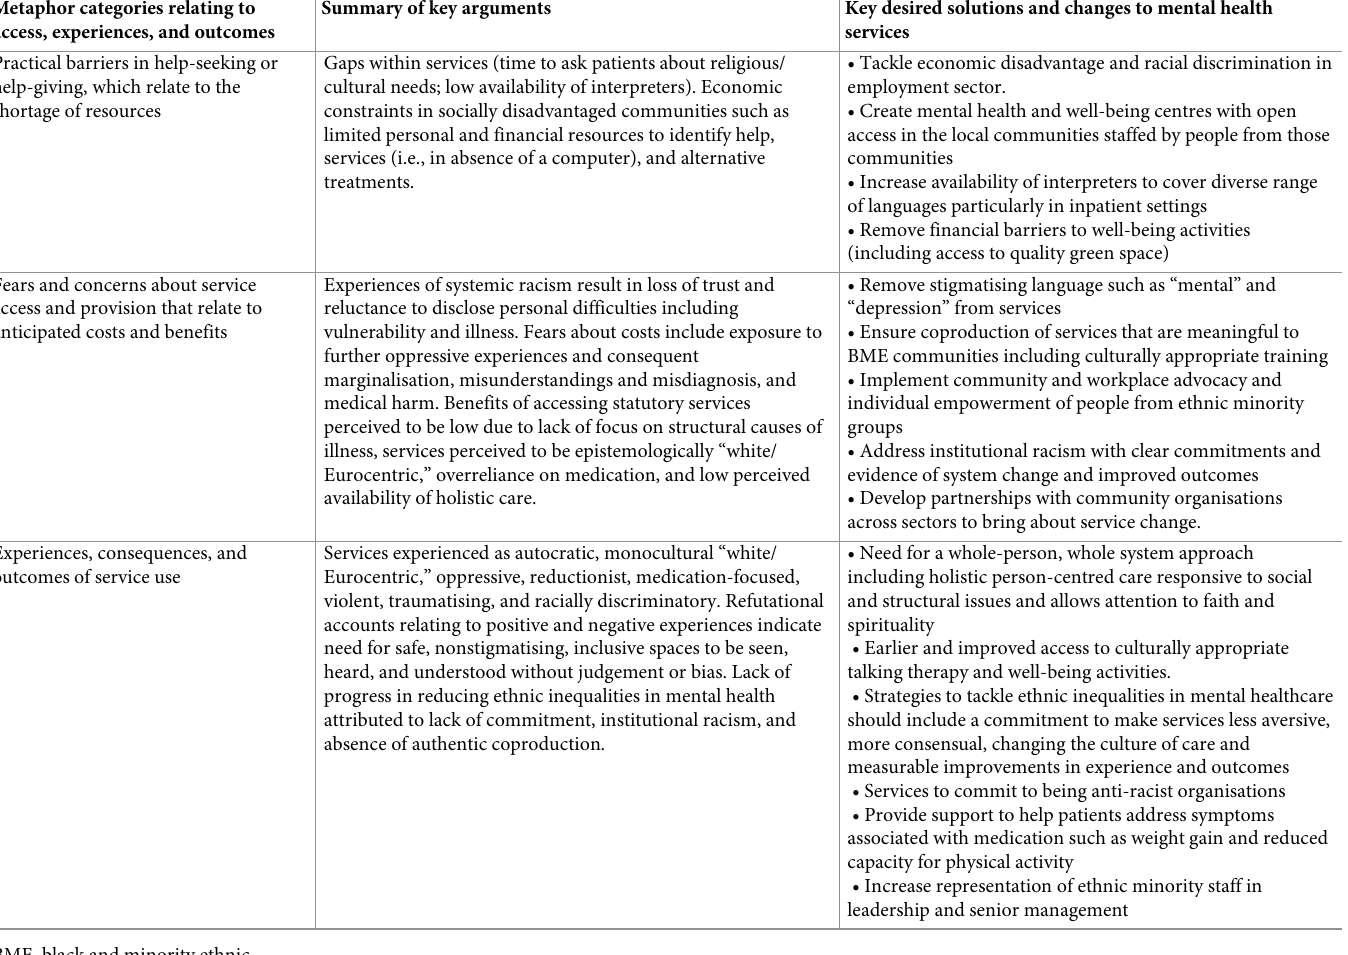
Table 4. Desired solutions and changes to improve access, experience, and